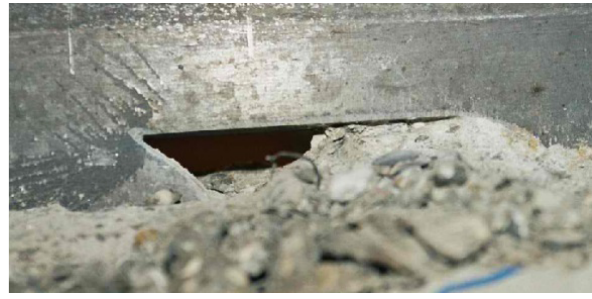
Figure 19: Plastic deformations of steel dowels in the region of the sharp notch in the SA shape (push-out specimen [30]).